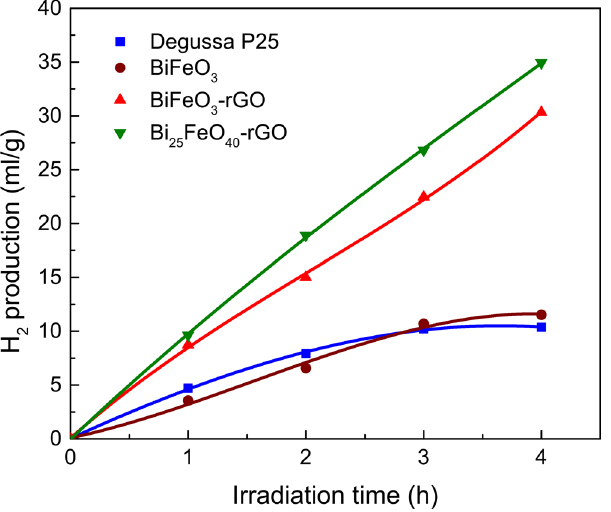
Figure 5. The volume of evolved hydrogen versus irradiation time for Degussa P25, BiFeO 3 , BiFeO 3 -rGO, and Bi